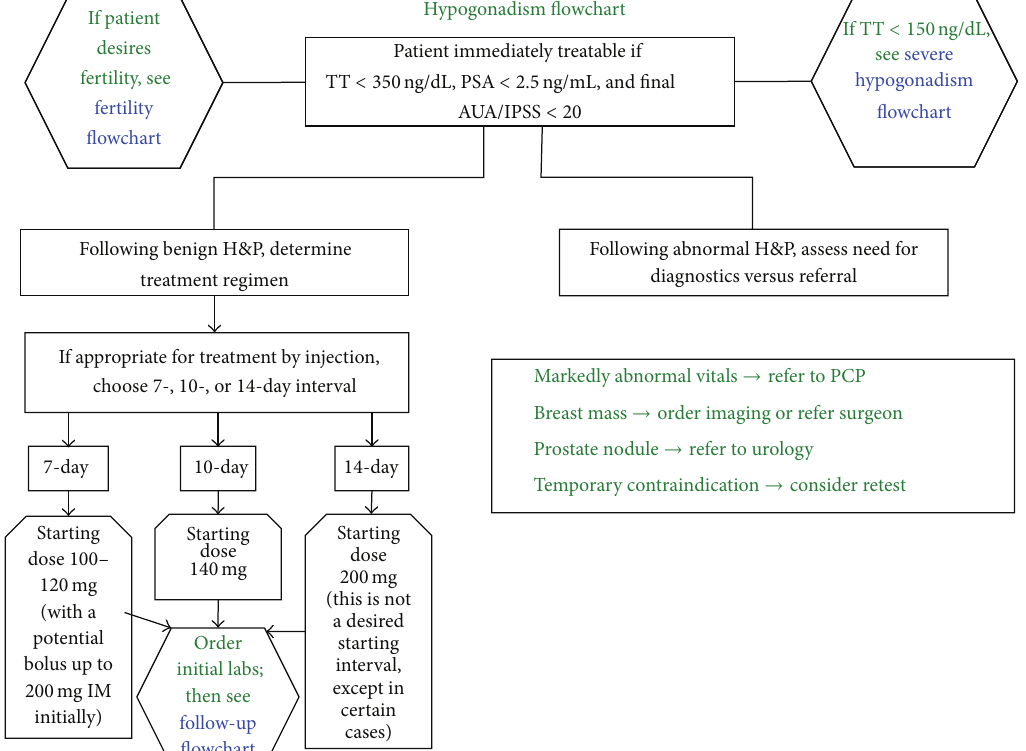
Figure 1: Flow diagram for patient enrolment protocol in a Low T Center.